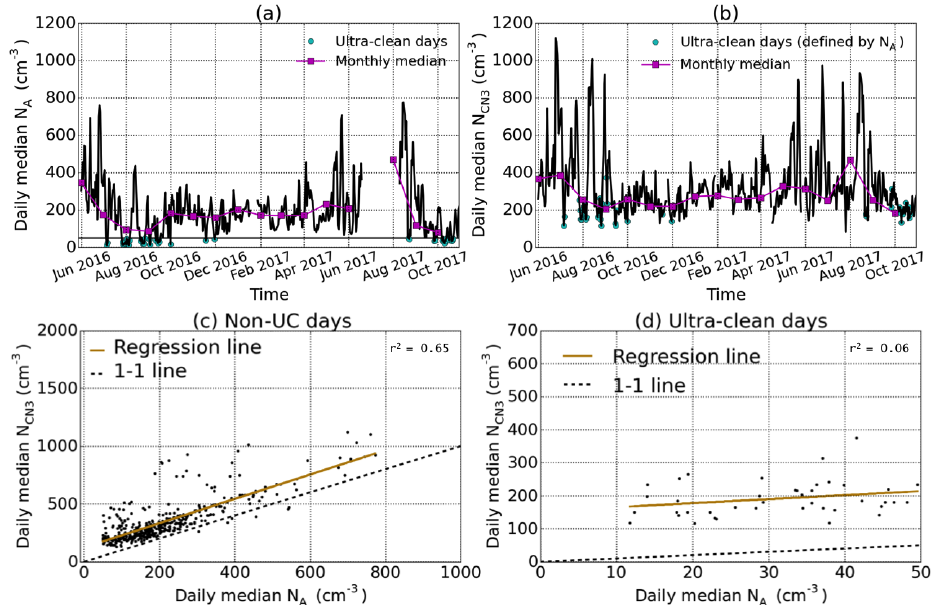
Figure 1. Time series of daily and monthly median (a) N A and (b) N CN3 measured during LASIC, with ultra-clean days marked in cyan. In panels (a) and (b) , vertical grid lines mark the first of each month labeled on the tick. Daily median N CN3 is then regressed against daily median N A for both (c) non-ultra-clean days and (d) ultra-clean